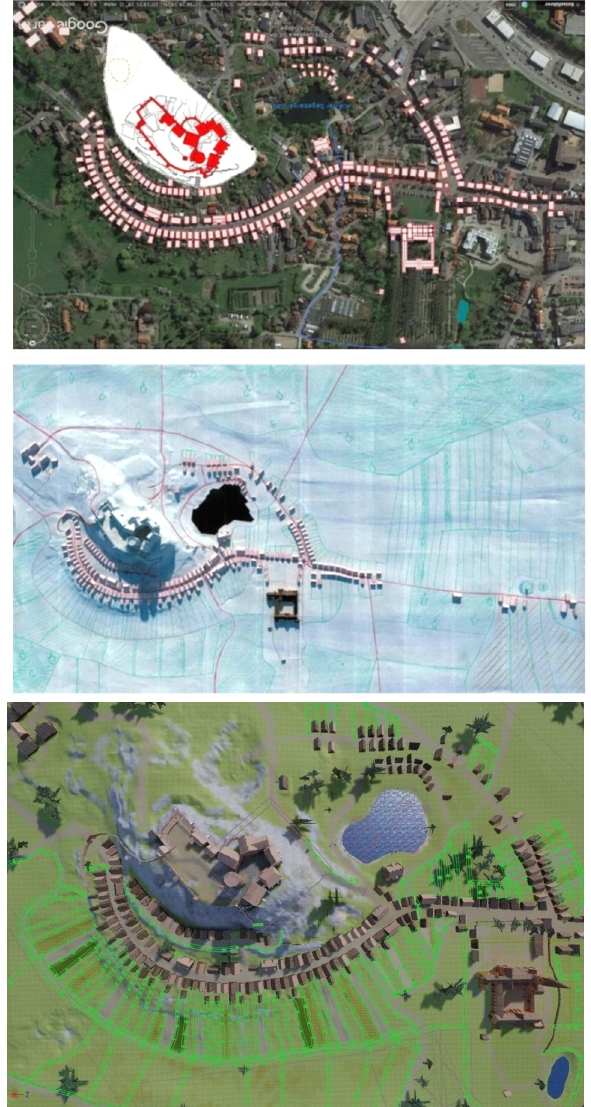
Figure 8. Aerial orthophoto superimposed with historic buildings (top), raw 3D model with landscape and property sketch (centre), and textured 3D model in the Unreal Game Engine (bottom, green lines represent fences for property areas). For better comparison with the engraving, south is